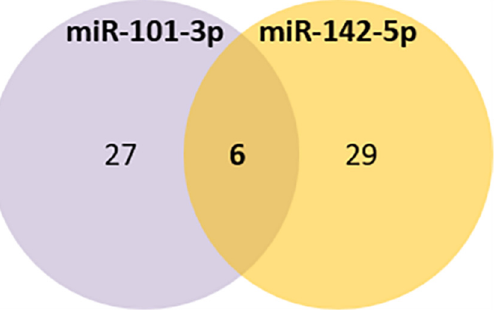
Figure 4. Venn diagram of the common aging targets predicted for miR-101-3p and miR-142-5p.